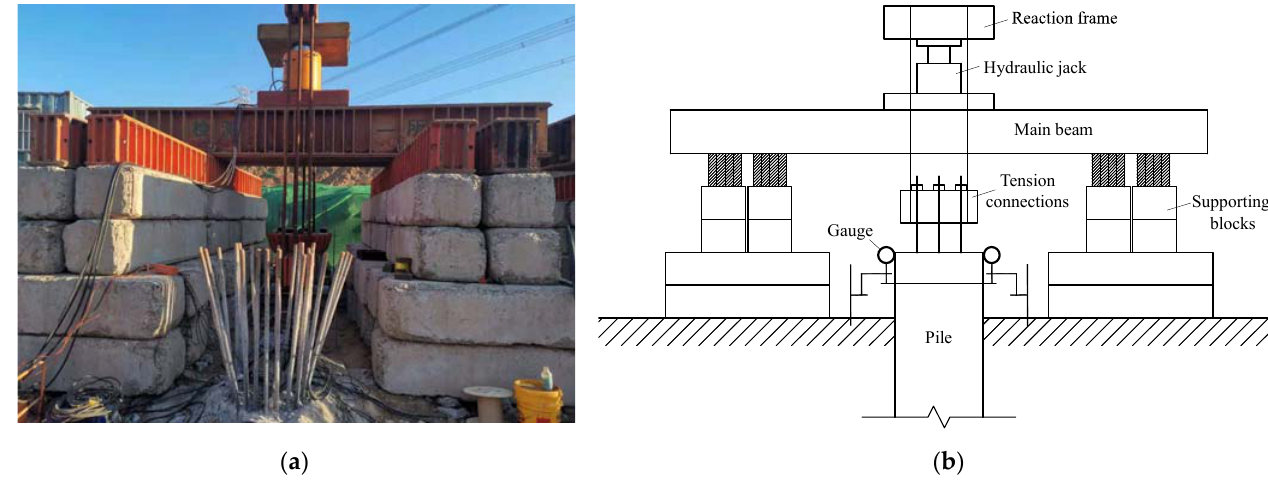
Figure 3. Experimental setup for static load test: ( a ) photo of the field; ( b ) schematic diagram.